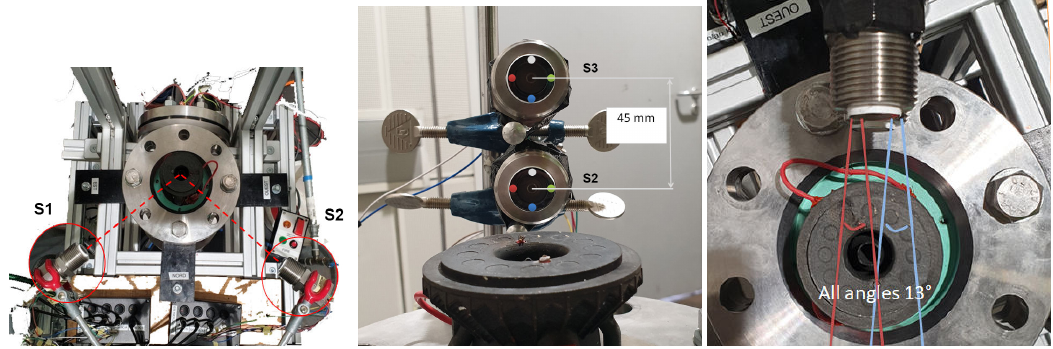
Figure 14. Optical arrangement for the atmospheric tests without pressure